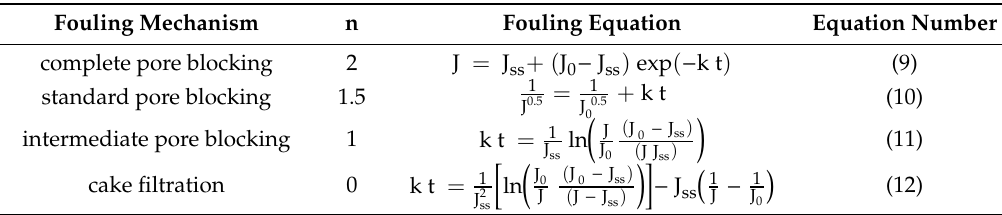
Table 2. Mathematical formulation of fouling phenomena for cross-flow filtration, based on the published definitions of J 0 , J ss , n, and k [29].